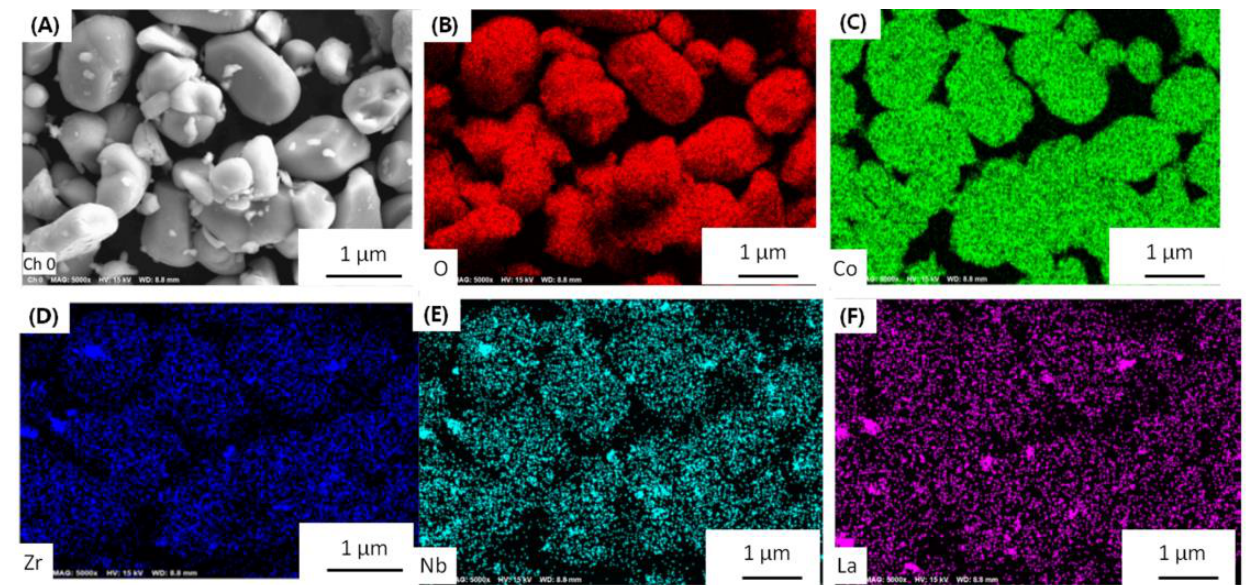
Figure 2. SEM image of LLZO&LNO@LCO.